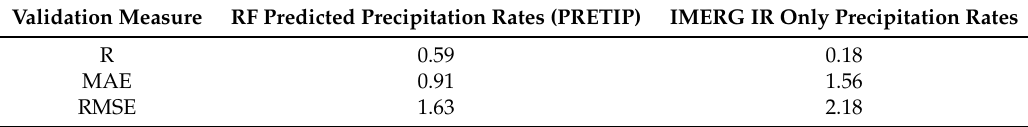
Table 2. Comparison of predicted precipitation rates with IR only precipitation both with reference to the gauge calibrated MW precipitation based on the validation measures. Validation Measure